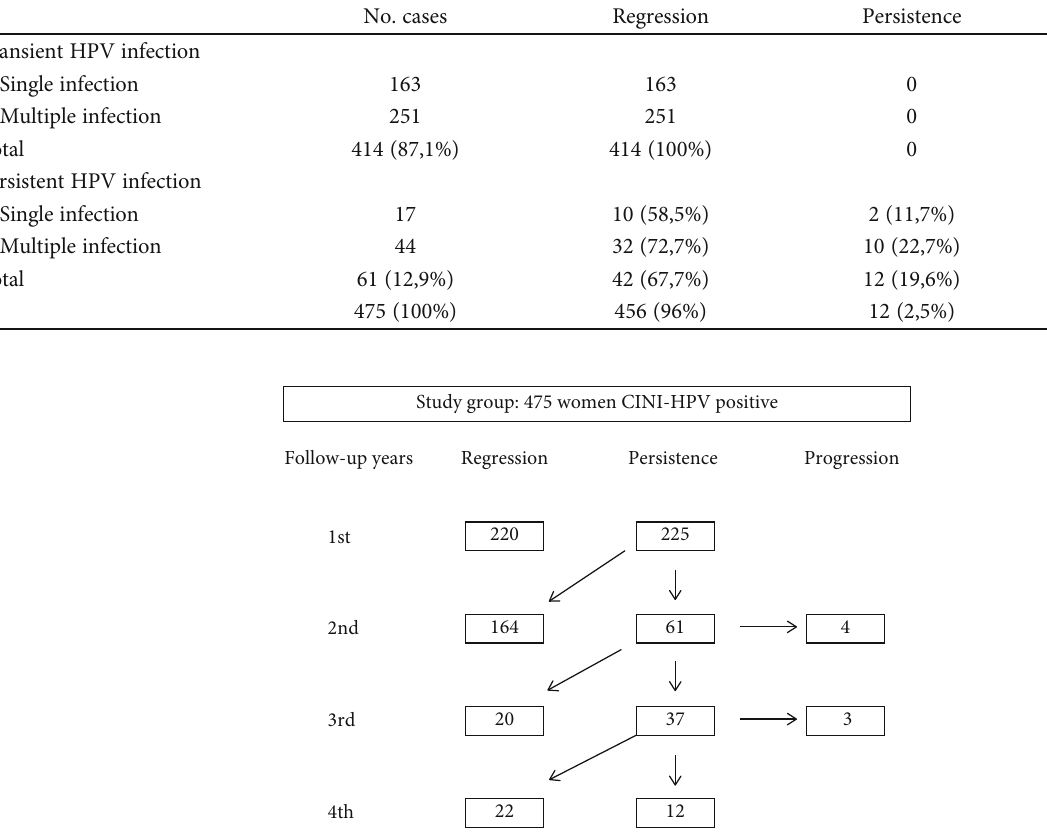
Figure 1: Flow Chart of the regression, persistence, and progression histological during 4 years of follow-up in the study group. Table 2: Analyzing the histological exams of the cones of the 6 cases that progressed to CIN3, we found the coexistence of CIN1 and CIN3 lesions in all